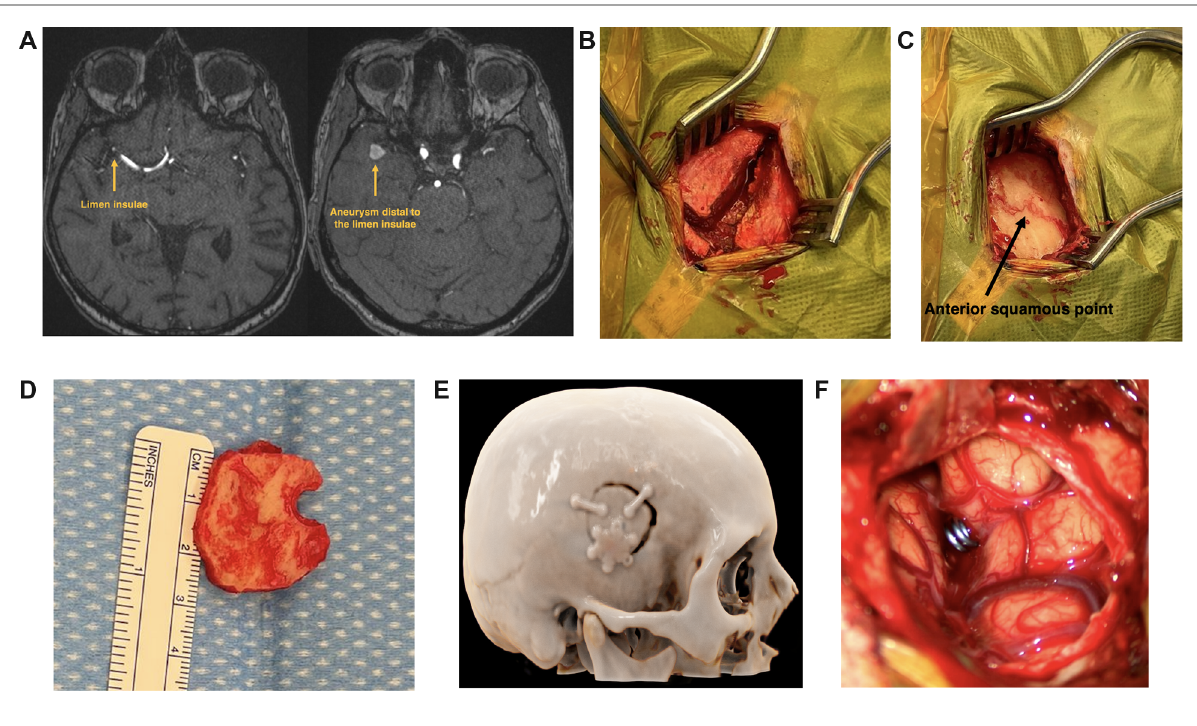
FIGURE 6 Sylvian keyhole approach case. ( A ) Native time of fl ight angiography MRI with a right-sided MCA aneurysm, located distally to the limen insulae. ( B ) Temporal muscle incision (T-shape incision). ( C ) The craniotomy is typically centered around the anterior squamous point. ( D ) 2.5 cm×2.5 cm sized craniotomy. ( E ) Cinematic rendering of the postoperative CT-scan, showing location and size of the SKA. ( F ) Focal opening of the sylvian fi ssure (1.5